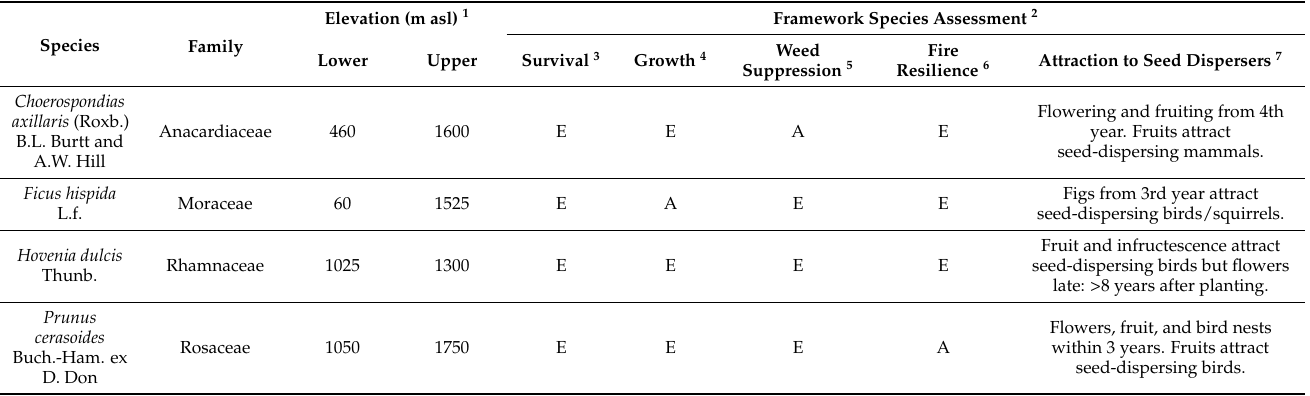
Table 1. Information of the four species. Overall, they are excellent framework tree species for forest restoration.